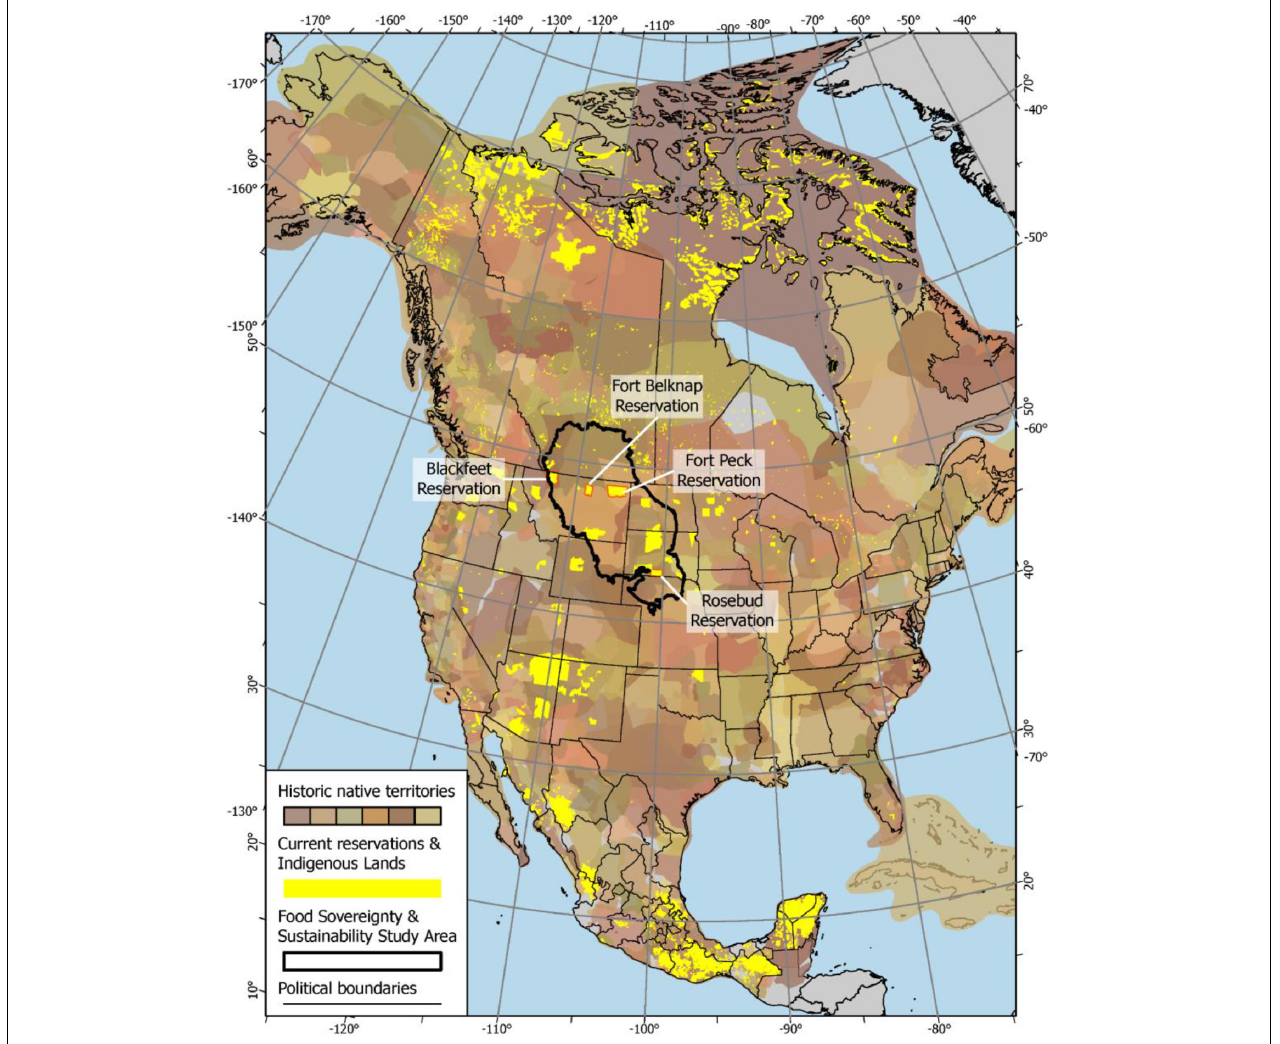
FIGURE 1 | Native territories were derived from Native Land Digital (https://native-land.ca/). Reservations and Indigenous Lands are from National Atlas of the United States (US), Indigenous communities (60–100% of population) from Mexico Indigena, and Aboriginal Lands of Canada from Geobase. Colors represent a gradient of historic native territories throughout North America, to emphasize the scale and diversity of Native American societies prior to being forced onto reservations. We note that tribal territories were fluid and underwent many shifts prior to, and during, European colonization, thus this map is only one such snapshot in time. For this reason, we omit the names of specific Tribes, instead using a gradient of tribal territories to highlight amount of land lost in comparison to where these communities currently